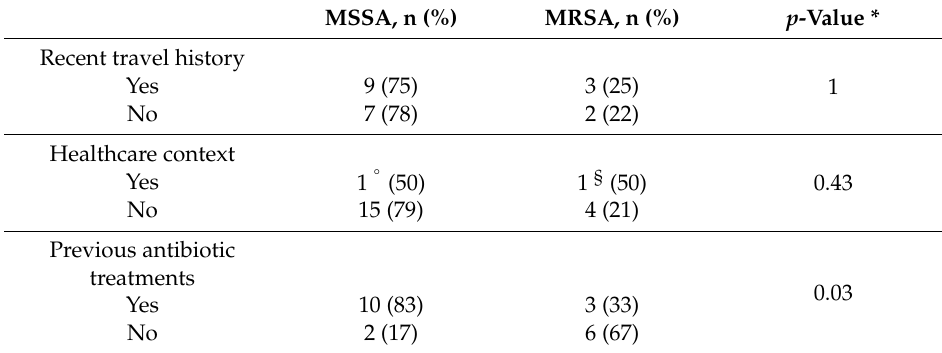
Table 3. Comparison between methicillin-sensitive Staphylococcus aureus and methicillin-resistant Staphylococcus aureus